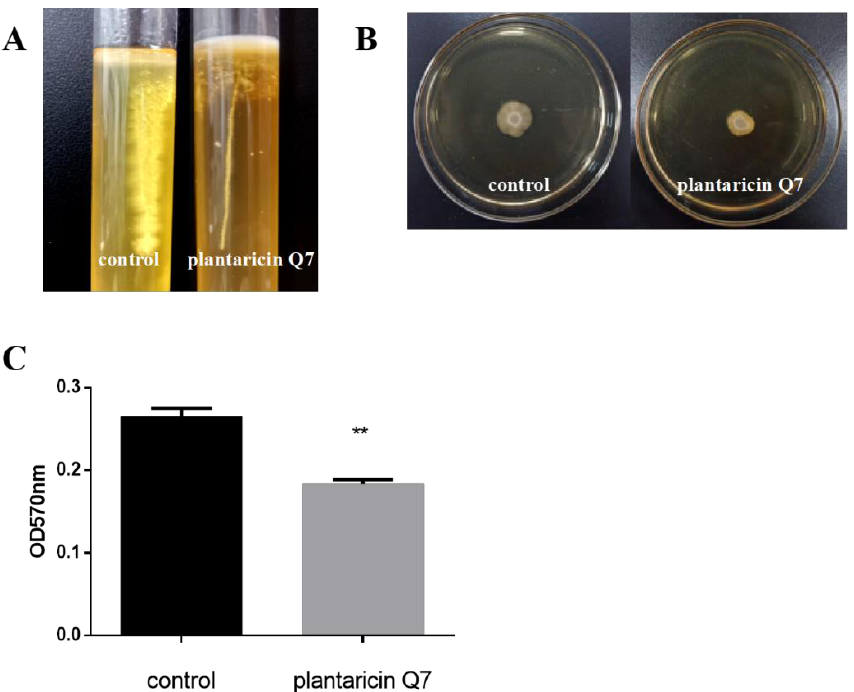
Figure 5. Effects of plantaricin Q7 on the motility and attachment of L. monocytogenes . ( A ) L. monocytogenes flagellum puncture test. ( B ) Effect of plantaricin Q7 on crawling movement ability of L. monocytogenes . ( C ) Effect of plantaricin Q7 on the ability of L. monocytogenes to attach fibrinogen. The data were shown as mean ± SD ( n = 3). ** p < 0.01.